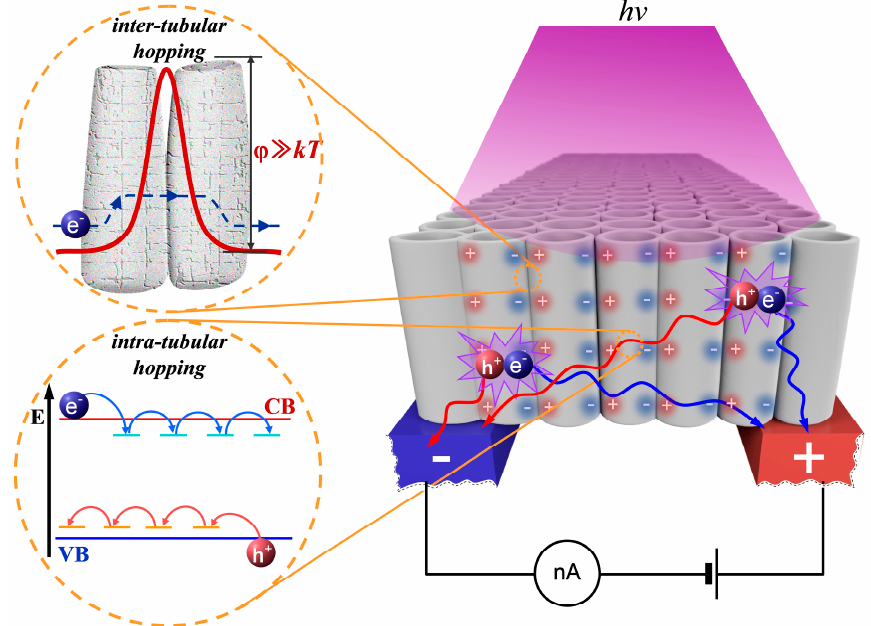
Figure 8. The cartoon displaying electrical processes in aTNTA under laser irradiation.